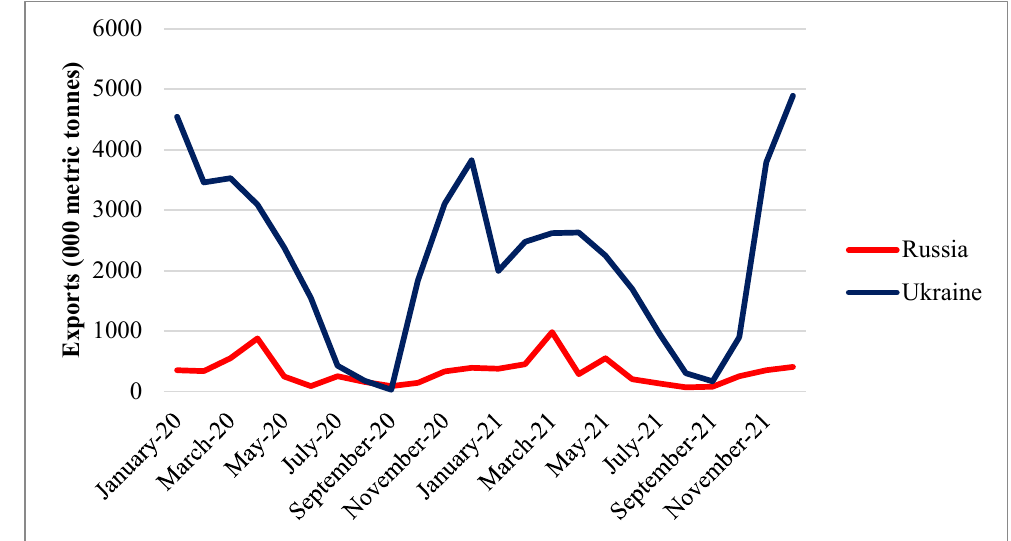
Figure 12. Export quantity of Russian and Ukrainian maize in 2020 and 2021. Source: [30]. The destination countries for maize exports from Ukraine are countries with upper- middle economies, such as China, the Netherlands, Egypt, Spain, and others. Likewise, Russia also sells maize to countries such as Turkey, Vietnam, the Republic of Korea, China, and others (Figure 13).